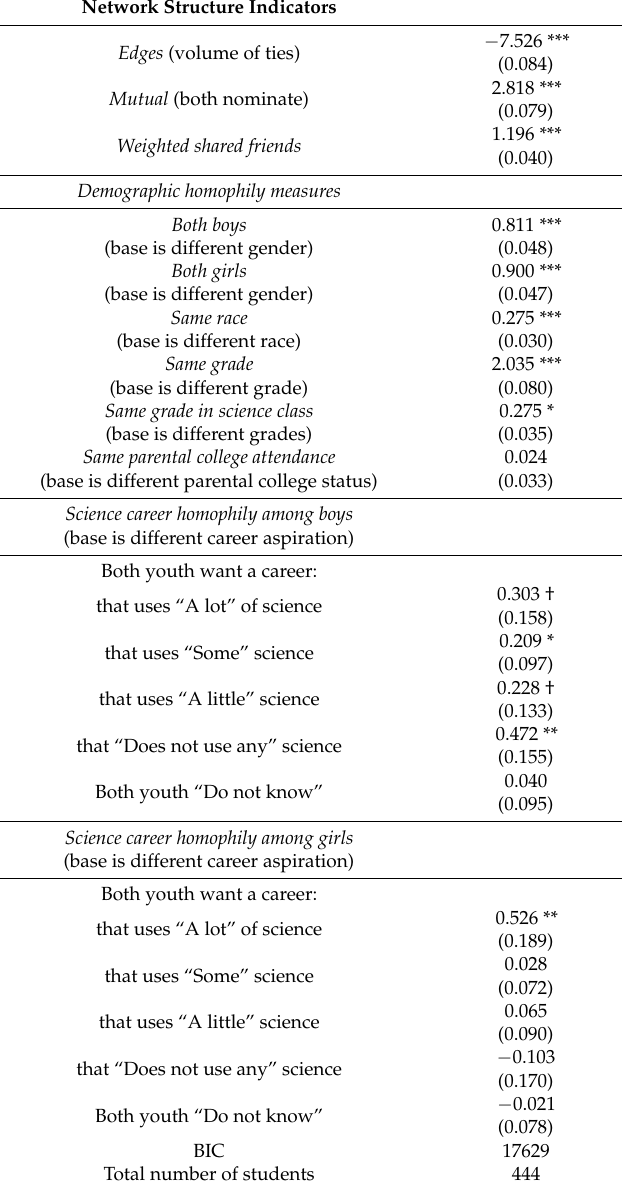
Table A1. Exponential random graph model of friendship ties (outcome) by network structure indicators, demographic homophily measures, and science career